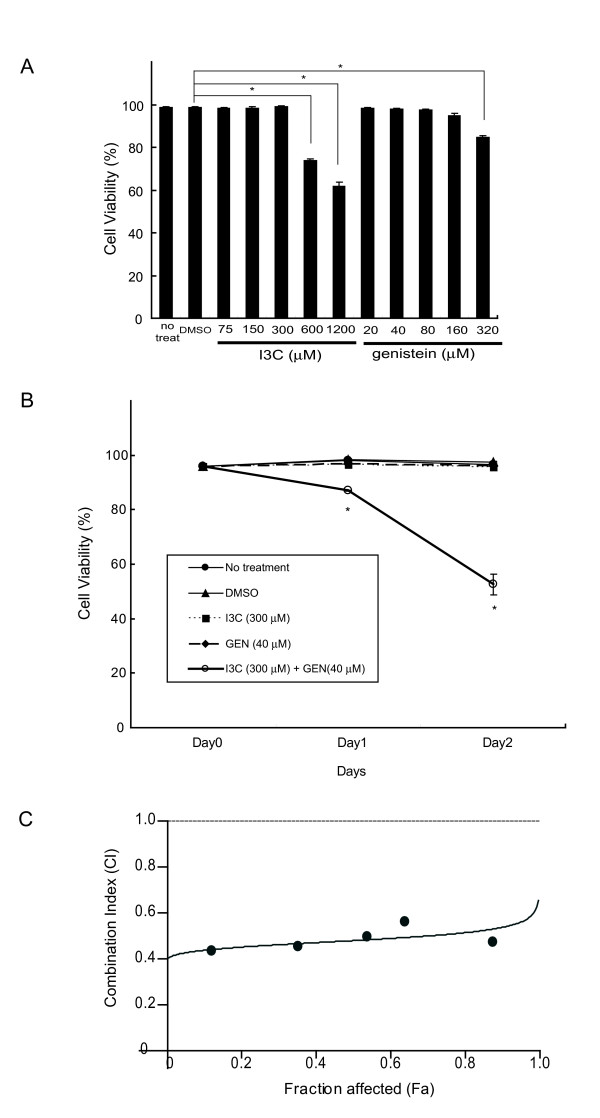
Inhibitory effects of I3C and genistein on cell viability in human colon cancer HT-29 cells. A, Viability of HT-29 cells 48 h after exposure to increasing doses of I3C or genistein as indicated. B, Time-dependent viability of HT-29 cells not treated (black circle) or treated with DMSO (black triangle), I3C (300 μmol/L) (black square), genistein (40 μmol/L) (black triangle), or a combination of I3C (300 μmol/L) and genistein (40 μmol/L) (white circle) for up to 2 days. The cell viability assay was performed as described in Materials and Methods. Columns and points, mean (n = 3); bars, SD. *, P < 0.05, significantly different compared with the DMSO-treated control. GEN, genistein. C, HT-29 cells were exposed to increasing concentrations of I3C and genistein, either alone or in a fixed ratio of 7.5:1, for 48 h, as described in Materials and Methods. The Fa-CI plot was constructed using experimental data points (dark circles) and by simulating CI values over the entire range of Fa values (line) using CalcuSyn software. Synergy, additivity, and antagonism are defined as CI<1, CI = 1, and CI>1, respectively.